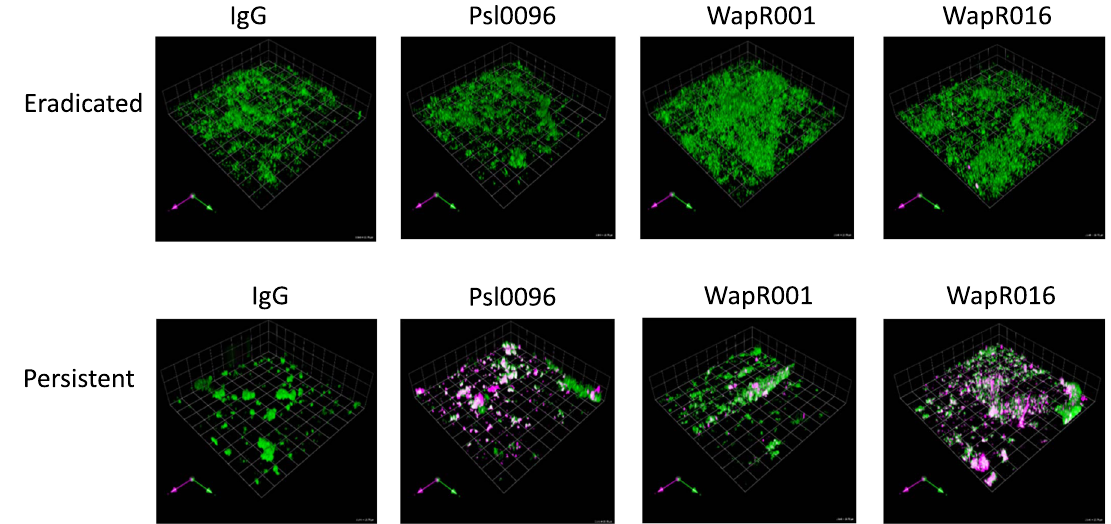
Fig. 2 P. aeruginosa isolates were grown as bio fi lms for 48 h then incubated for 90 min with fl uorescently labeled anti-Psl antibodies (IgG control, Psl0096, WapR01, and WapR016). Representative images are shown for a SickKids eradicated (Pa50) and persistent (Pa565) isolate, where bio fi lms are stained green and the antibody binding is